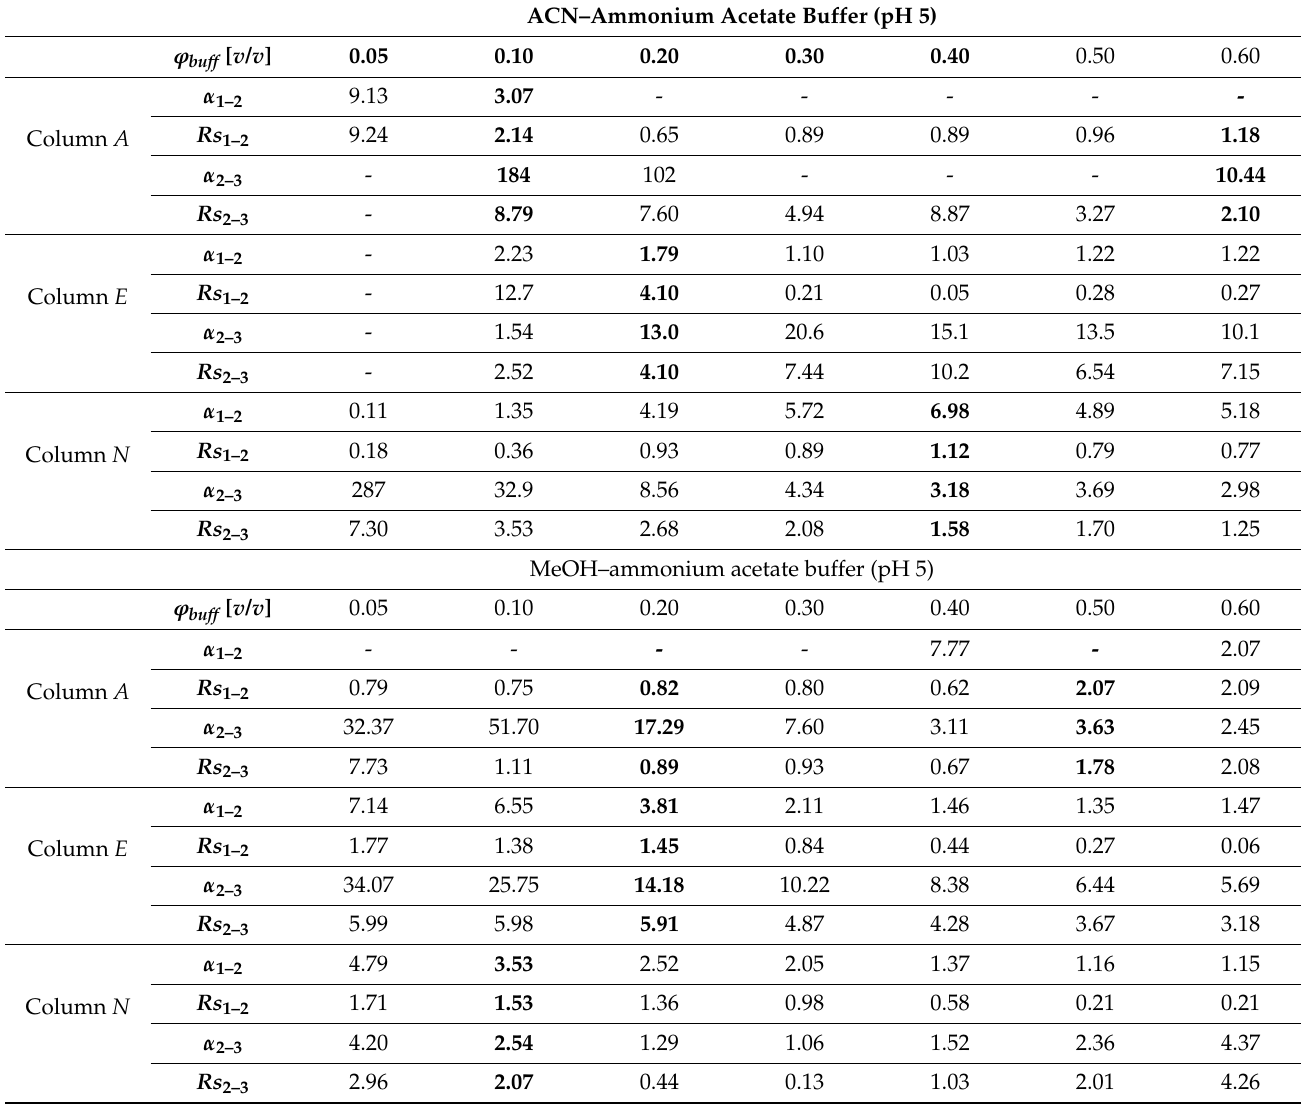
Table 5. Selectivity coefficient α and column resolution coefficient Rs values in the chromatographic systems applied in the first stage of